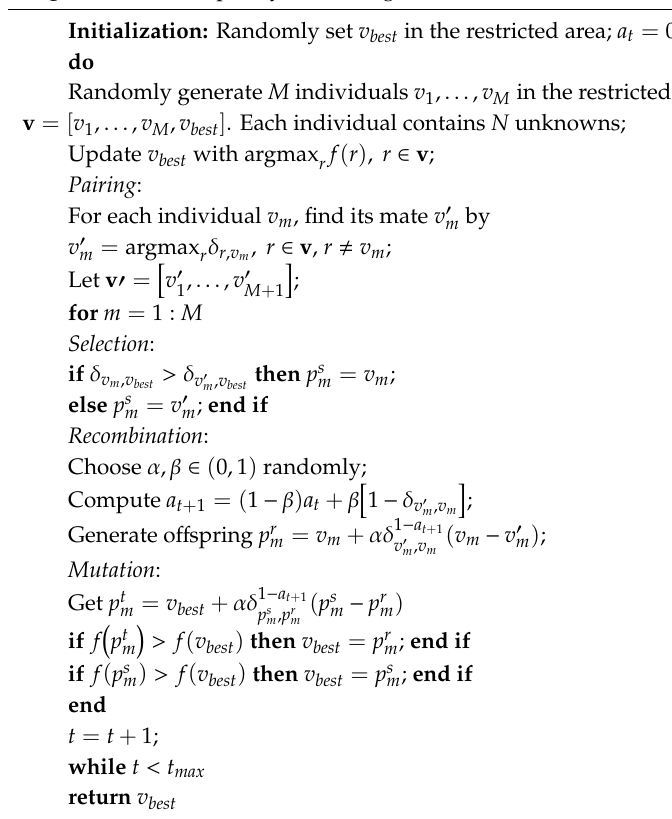
Algorithm 1 Participatory Search Algorithm